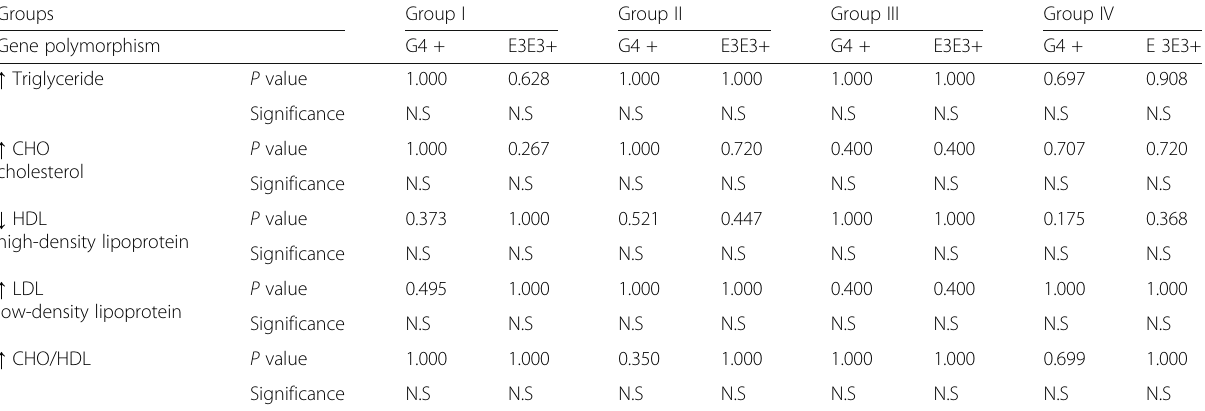
Table 10 Association between plasminogen activator inhibitor G4 polymorphism and APO-E (E3E3) polymorphism with each pattern of dyslipidemia Groups